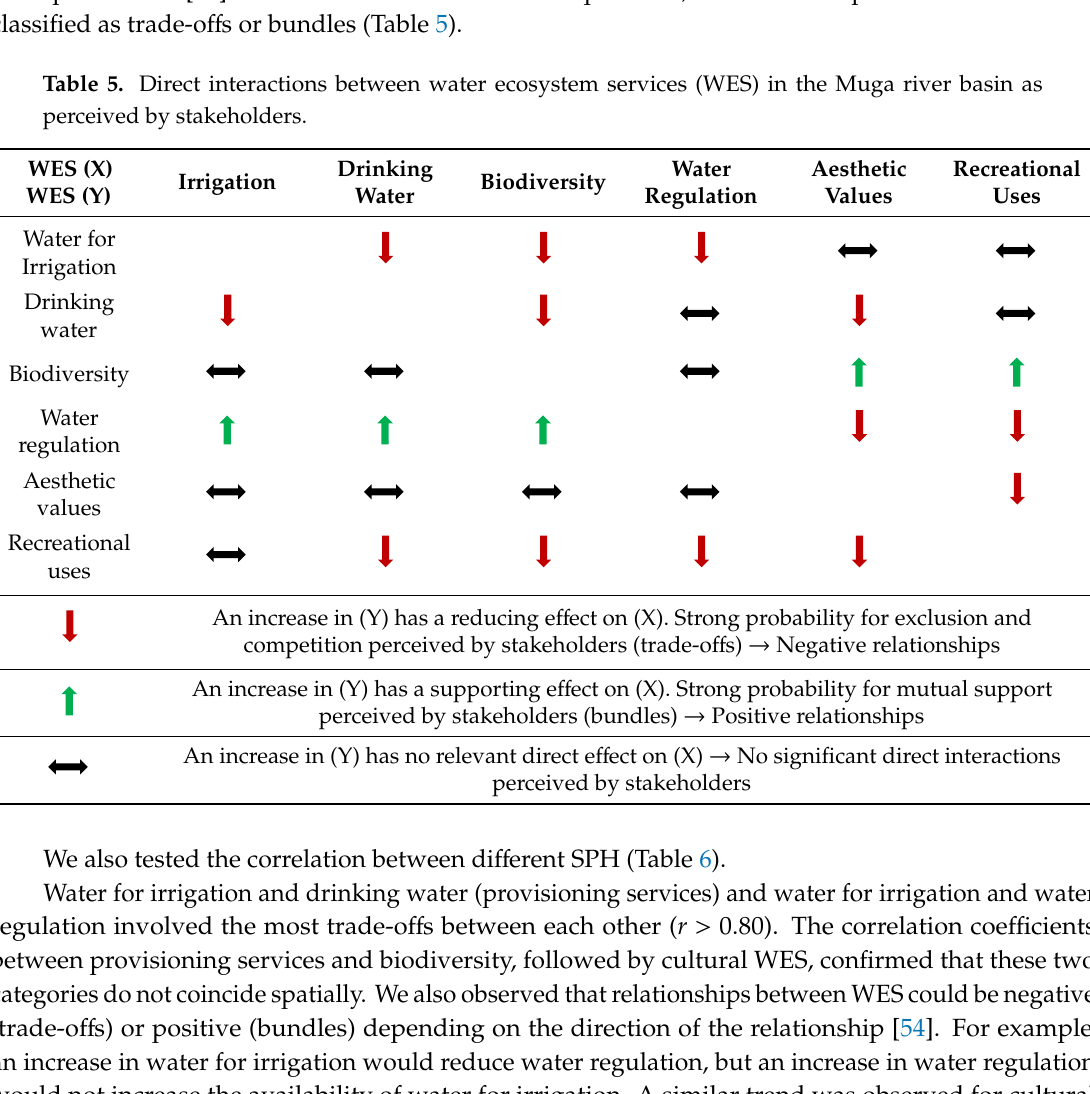
Table 6. Spatial correlation between provisioning water ecosystem service hotspots (SPH) generating trade-offs. Yellow color represents trade-offs; green color represents synergies (bundles); grey color represents partial spatial match. Spatial match and trade-offs → Negative relationships Spatial match and synergies ( bundles ) → Positive relationships SPH_ Irrigation